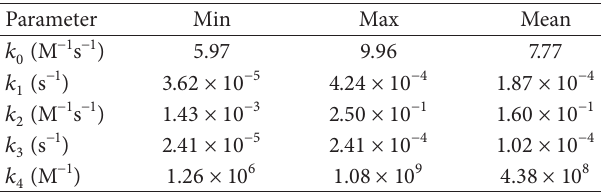
Table 2: Minima, maxima, and arithmetic mean of the kinetic parameters after the individual fitting of the 6 kinetic curves shown in Figure 2 corresponding to SA/V ratios of 0.4, 0.5, 0.57, 0.67, 0.8, and 1.0cm − 1